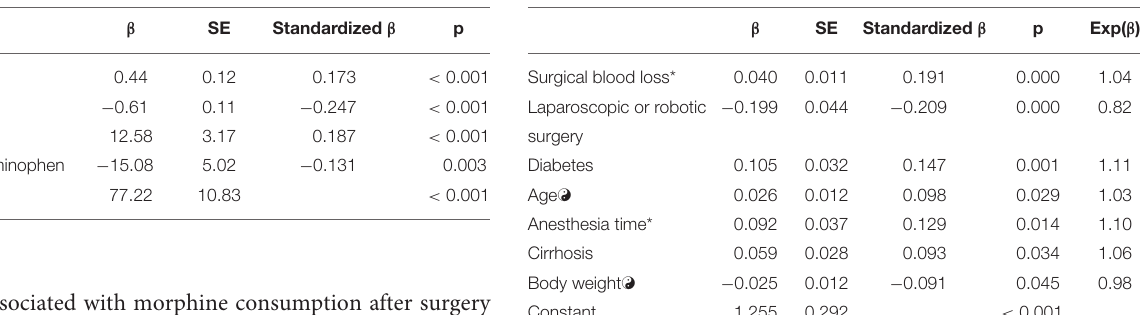
TABLE 4 | Predictors of morphine consumption. TABLE 5 | Predictors of length of hospital